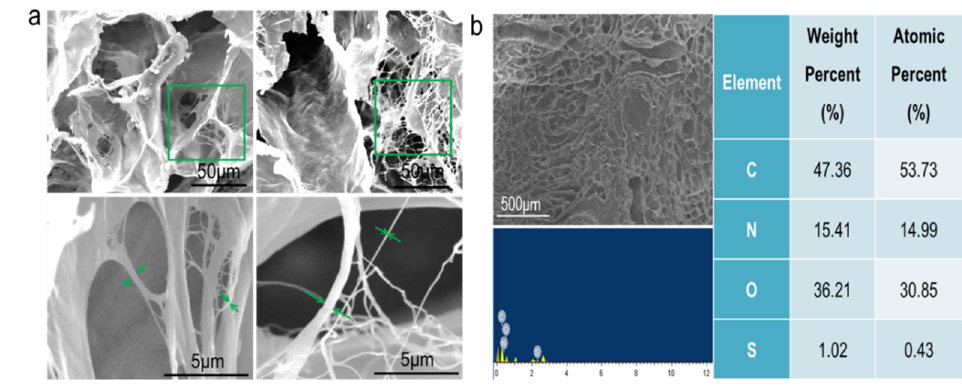
Figure 2. Microstructure analysis of pig kidney matrix scaffolds. ( a ) Reticular structure of pig kidney-derived matrix scaffold nanofibers; scale: 50 μ m (top), 5 μ m (under). ( b ) Element analysis of pig kidney-derived matrix scaffold.